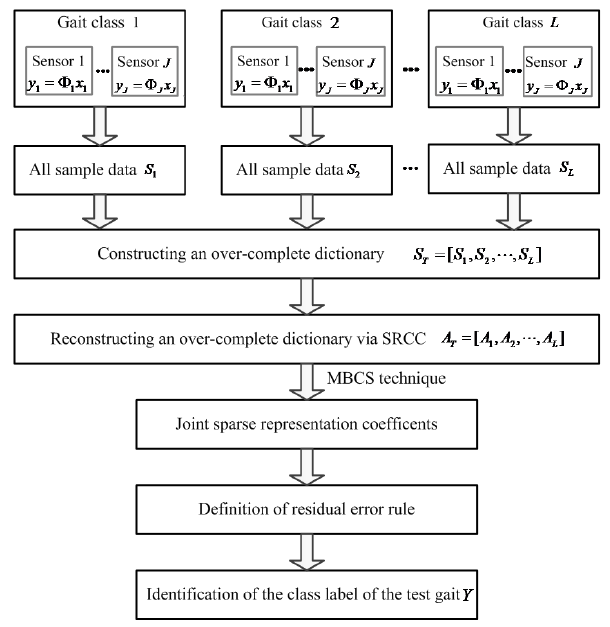
Figure 1. The block diagram of the proposed novel neighboring joint sparse representation classification (JSRC) model.